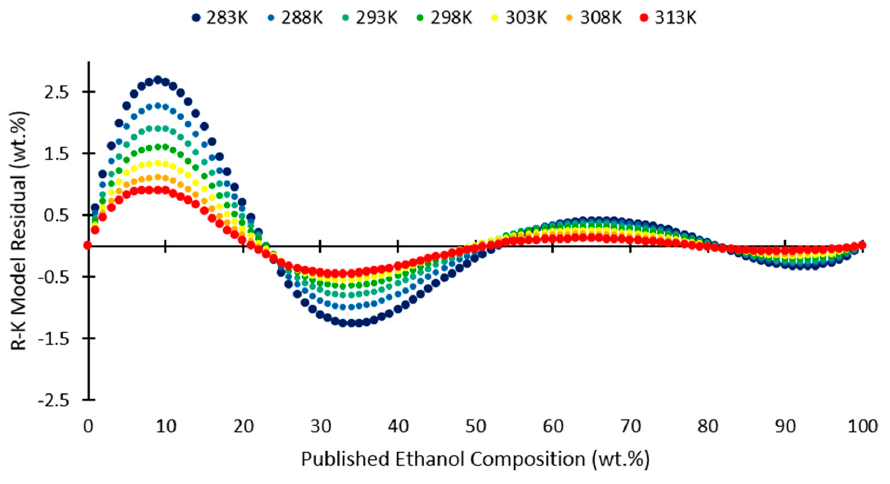
Figure 3. Weight percent (wt.%) residuals for mixture composition calculated using the Redlich-Kister model with coefficients regressed using temperature dependent density data between 0–100 wt.% ethanol.